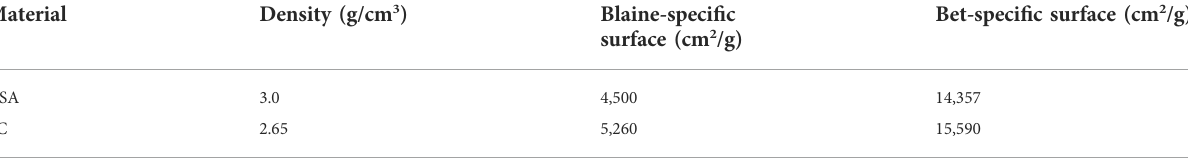
TABLE 3 Physical properties of the fl ash-calcined sediment SC and CSA.